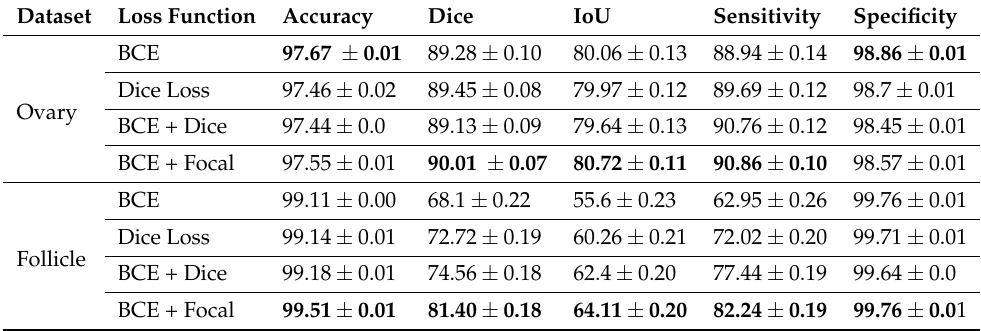
Table 5. Ablation study of the loss function. Statistically significant results are highlighted in bold.